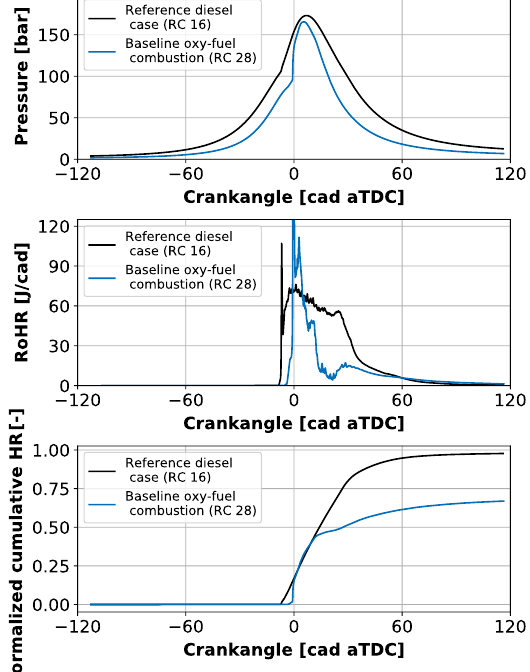
Figure 3. Comparison between the simulations of the reference diesel case against the baseline oxy-fuel combustion case, results of in-cylinder pressure ( top ), RoHR ( middle ) and normalized cumulative HR ( bottom